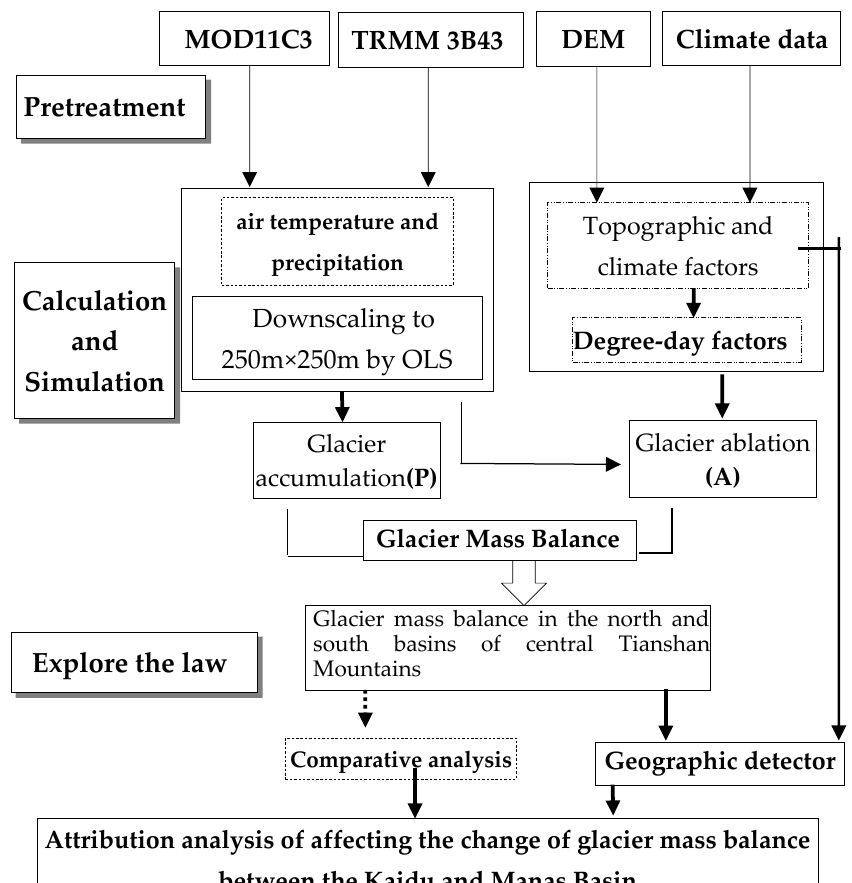
Figure 2. Methodology